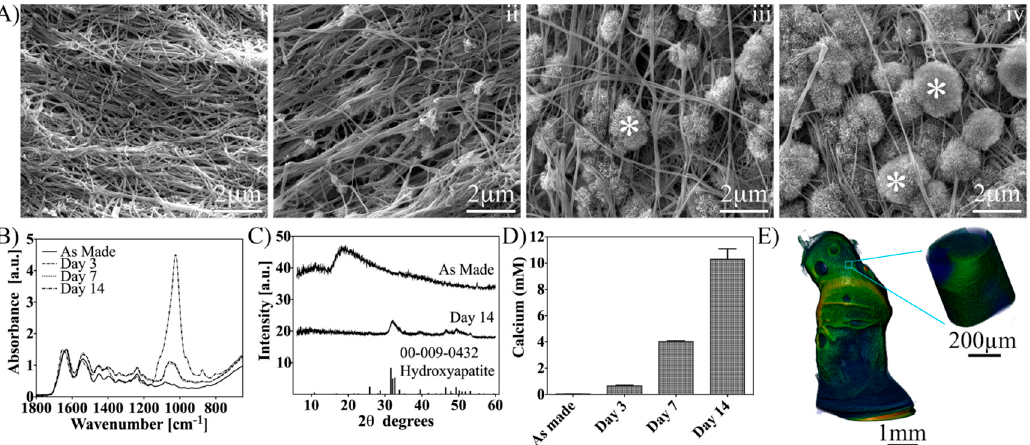
Figure 3. Characterization of acellular mineralization of sericin-functionalized DCF 2:1 gels up to day 14 in SBF. ( A ) SEM micrographs of as-made gels (i) and at days 3 (ii), 7 (iii), and 14 (iv) in SBF.